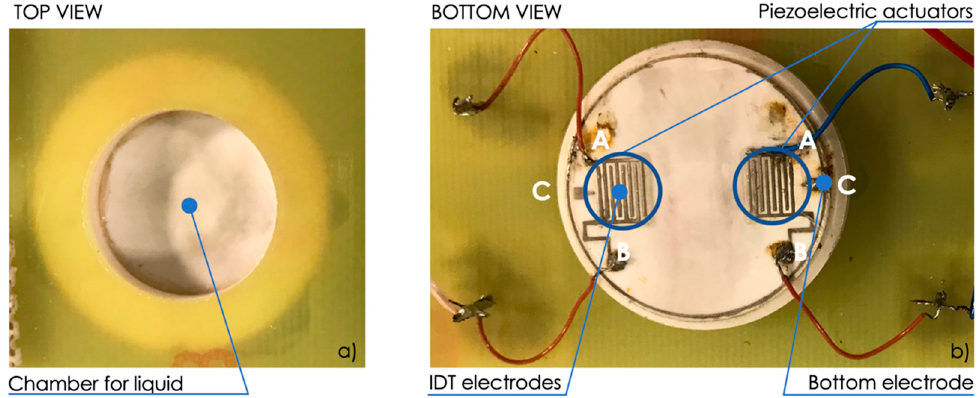
Figure 3. Top-view ( a ) and bottom-view ( b ) pictures of the fabricated device fixed to a printed circuit board (PCB).